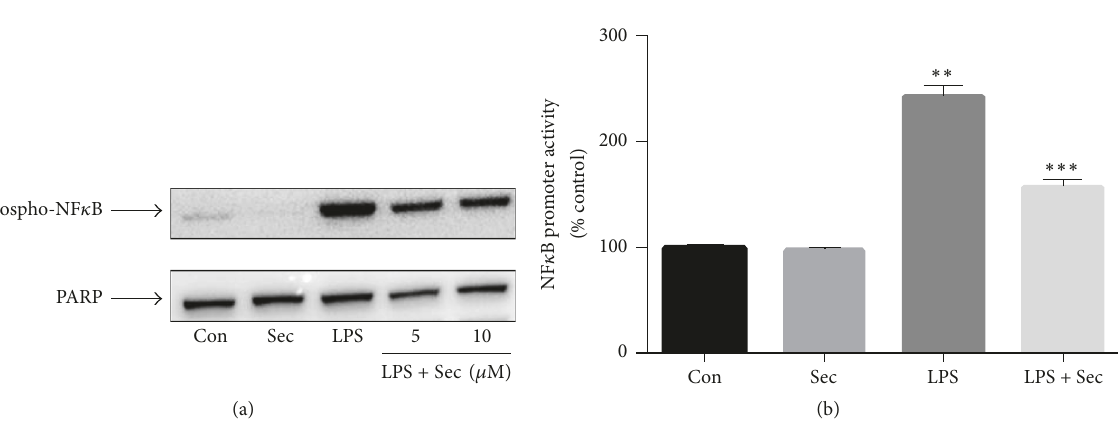
Figure 4: Securinine attenuates LPS-induced activation of NF- 𝜅 B in BV2 microglia. (a) BV2 microglial cells were treated with securinine for 1h followed by stimulation with 500 ng/mL LPS. After 30min of LPS stimulation, isolated nuclear lysates were subjected to Western blotting to assess translocation of phosphor-65 protein to the nucleus. PARP was used as a nuclear loading control. (b) BV2 cells were transiently transfected with NF- 𝜅 B-Luc plasmid for 24 h and then treated with 500 ng/mL LPS for 4 h ± securinine. Whole cell lysates were assayed via the luciferase activity (mean ± SE, 𝑛 = 4 ); ∗ 𝑃 < 0.05 versus control. ∗∗ 𝑃 < 0.05 versus LPS. ∗∗∗ 𝑃 < 0.05 versus LPS.